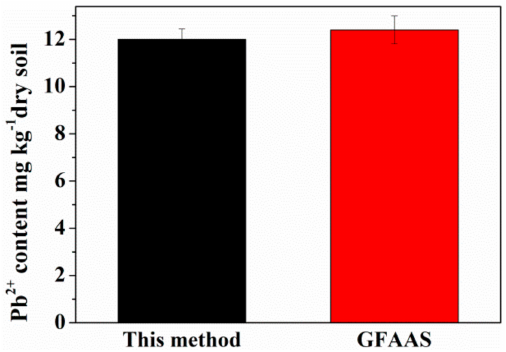
Figure 6. Relative current signal of the polluted